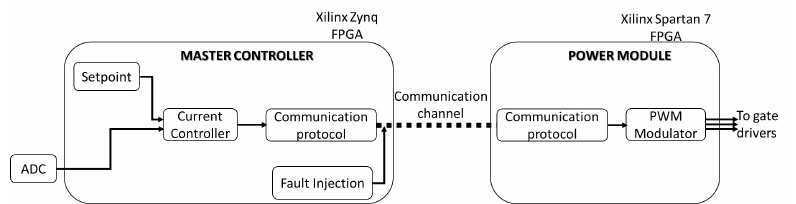
Figure 3. Schematic view of the implemented